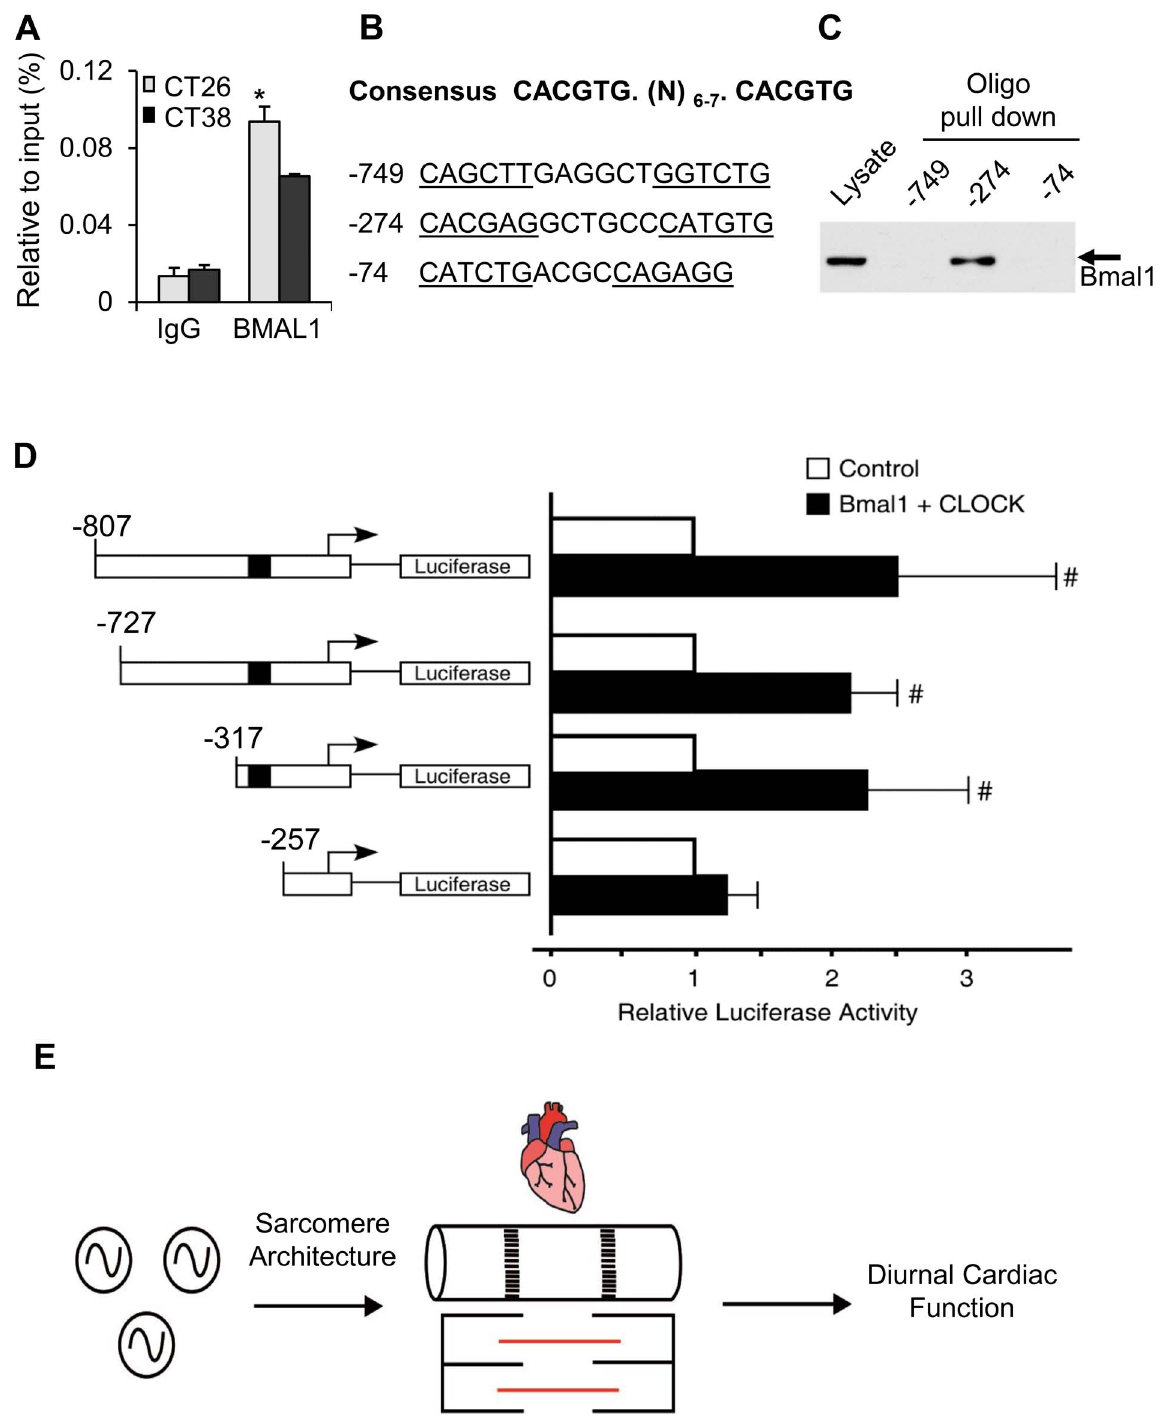
Figure 4. Tcap is a transcriptional target via binding to E-box motifs. ( A ) Chromatin immunoprecipitation (ChIP) assay performed using anti- BMAL1 antibody (n=3/time point). Rabbit IgG was used as a negative immunoprecipitation control. ( B ) BMAL1 binding motifs in three E-box consensus sequences in the Tcap promoter, with location relative to the TSS noted. ( C ) BMAL1 was strongly precipitated by the 2 274 E-box, by DNA precipitation assays using biotinylated oligonucleotides. ( D ) BMAL1 increased Tcap promoter activity, whereas deletion of sequences to 2 257 (relative to the TSS, deleting the 2 274 motif, represented as the black box) abrogated increases in Tcap promoter activity, by luciferase reporter assay. Mean 6 SEM, n=4, # =p , 0.05. ( E ) Illustration of circadian clock regulation of sarcomere architecture and thus diurnal cardiac structure and function. Left, ( , )=molecular clock mechanism; centre=cardiac sarcomere.